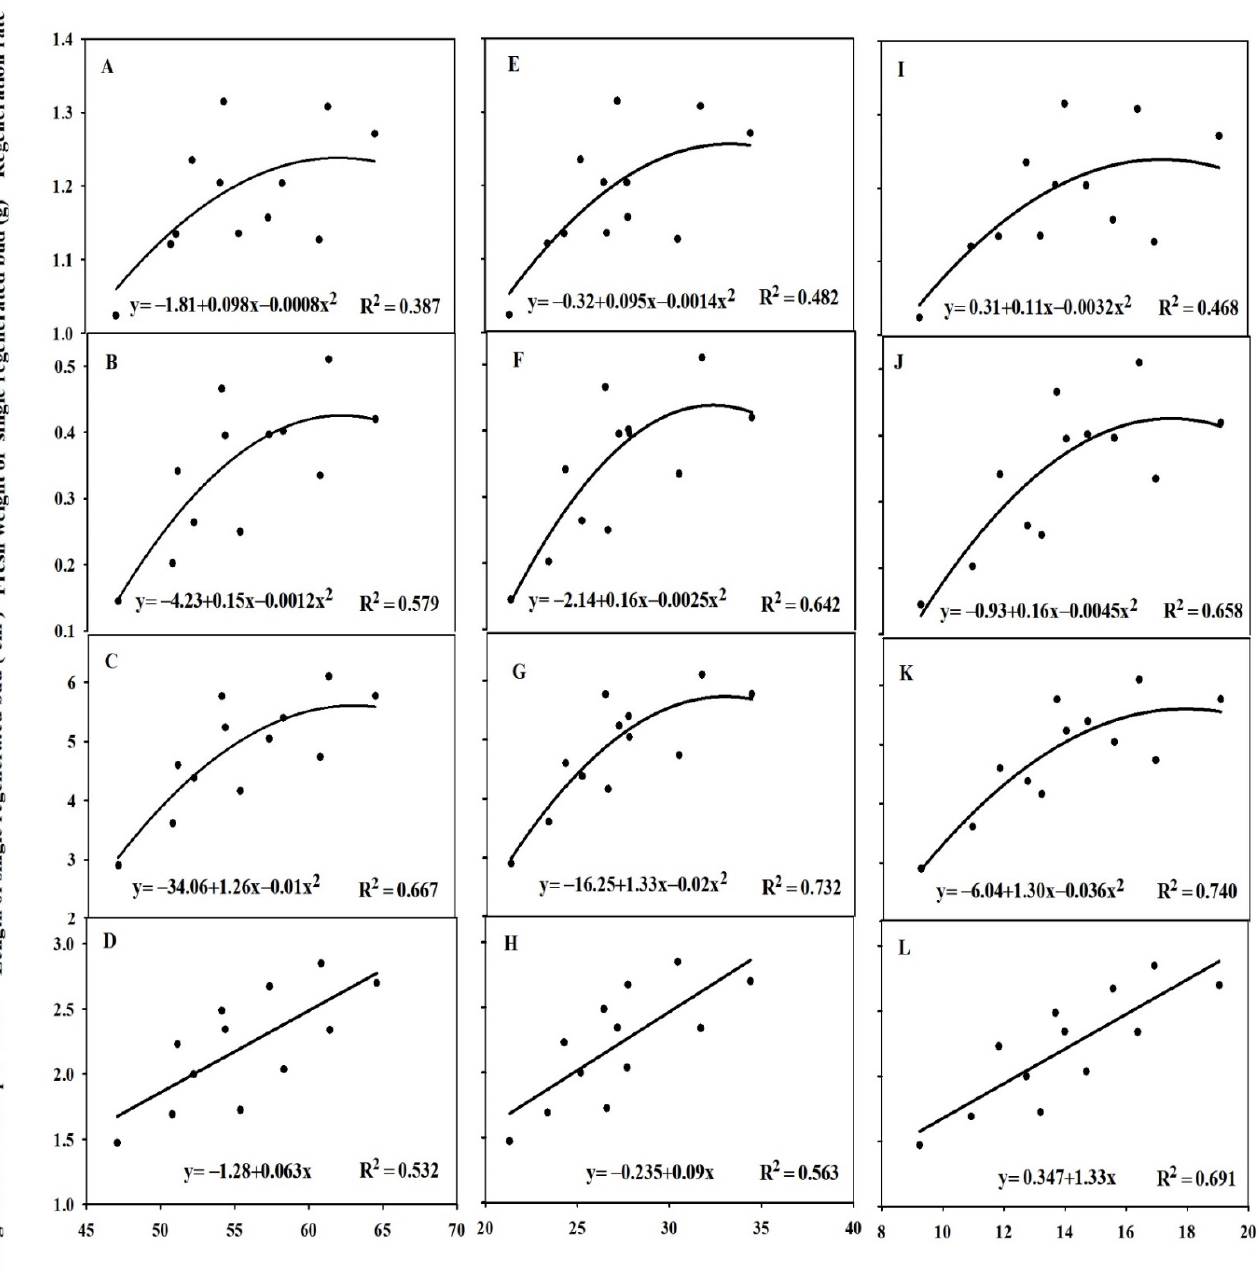
Figure 6. Relationships between root oxidation activity in the main crop and number ( D , H , L ), length ( C , G , K ), and fresh weight of regenerated buds ( B , F , J ) at maturity of main crop and regeneration rate ( A , E , I ). Note: HS, full heading stage of the main crop. DAH, days after heading of the main crop, MS, maturity stage of the main crop. ROA, root oxidation activity.